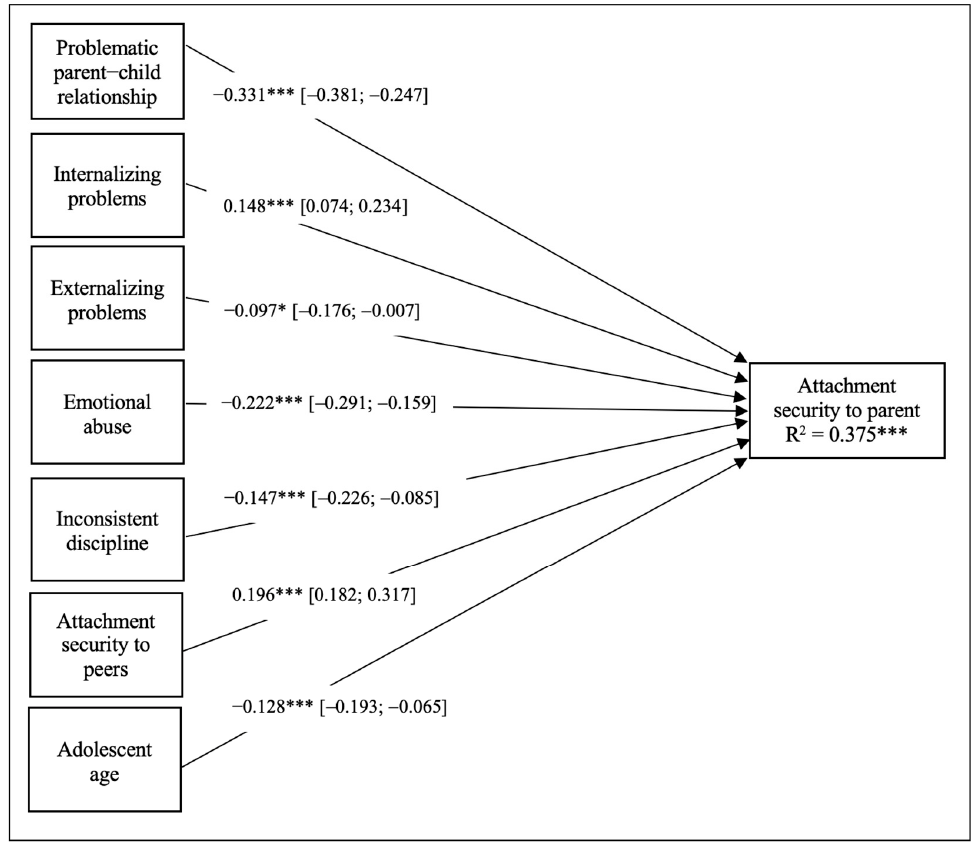
Figure 1. Factors associated with attachment security to parent—global model for boys and girls. Note. * p < 0.05; *** p < 0.001. The reported coefficients are standardized betas. CI = Confidence interval (95%). R 2 = R-Squared.